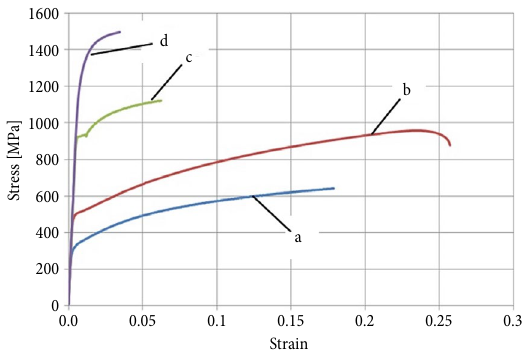
Fig. 7. Steel alloys: a – DP 500; b – TRIP 780; c – DP 980;